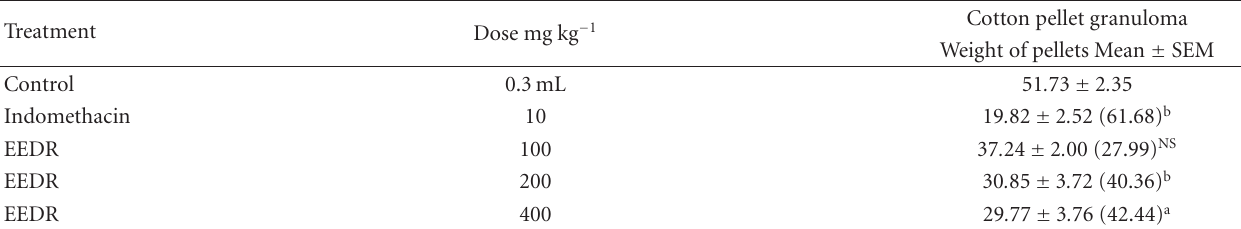
Table 2: E ff ect of ethanol extract of Delonix regia (100, 200 and 400 mg/kg) on cotton pellet granuloma in rats.